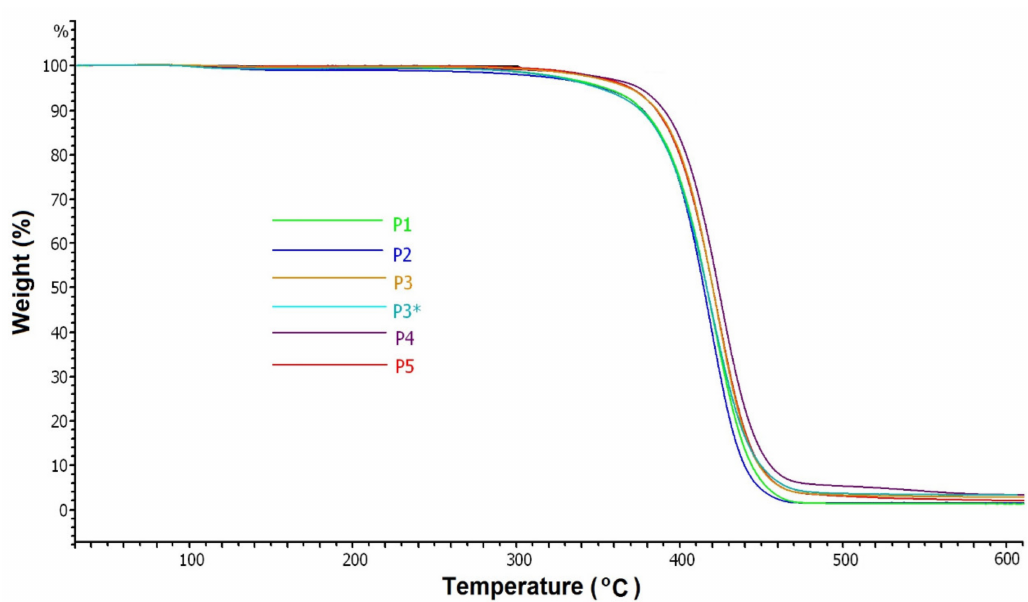
Figure 2. Thermogravimetric curves for polymers P1 – P5 .